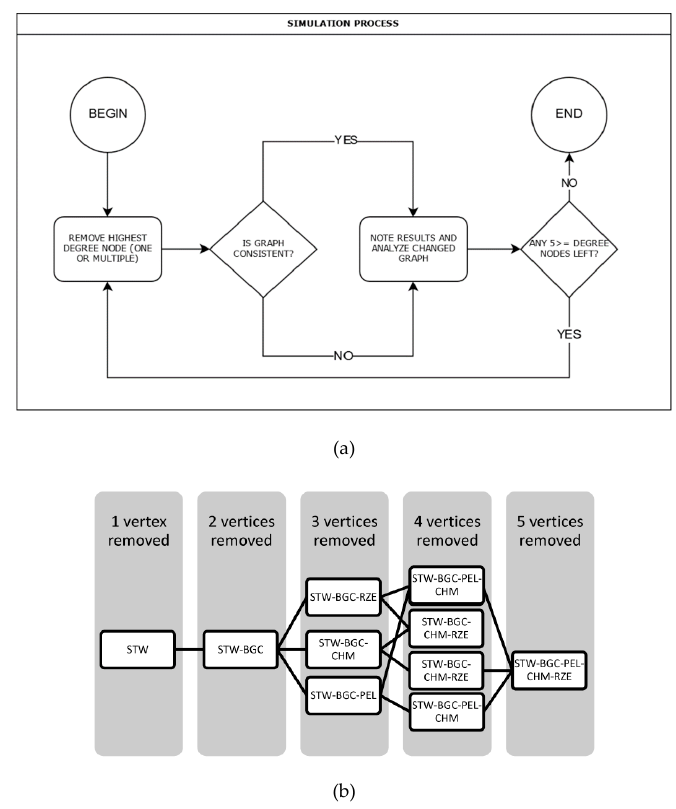
Figure 5. A flow chart of the proposed simulation procedure ( a ) and a schematic of the order in which vertices were eliminated during the analysis ( b